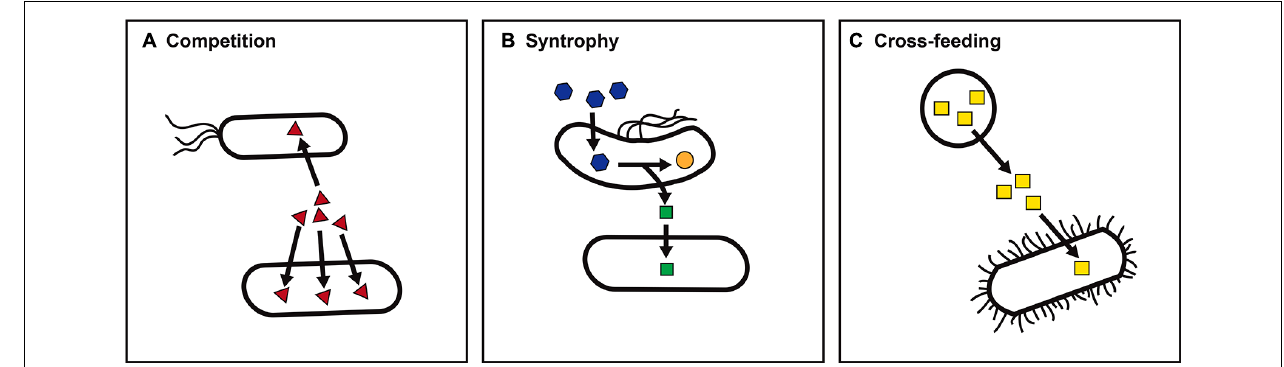
consumption of an intermediate or end product such as hydrogen (green squares) by a partner organism allows an otherwise energetically unfavorable reaction, for example, propionate (blue hexagons) to acetate (orange circles) to support growth. (C) Nutrient cross-feeding. The presence of a microbe that produces an essential nutrient such as folate (yellow squares) enables auxotrophs to